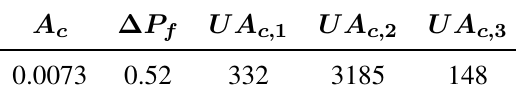
Table 2. Estimated parameters of the